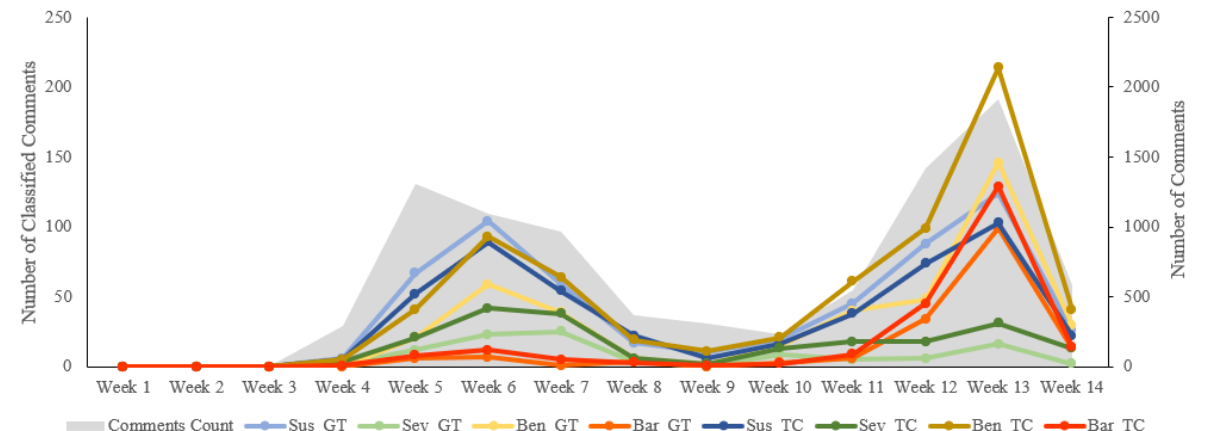
Figure 2. Classification of Ministry of Health comments with Health Belief Model constructs. The primary x-axis is for the classified comments count for the Health Belief Model constructs, while the secondary x-axis is for the total comments count. Sus refers to perceived susceptibility, Sev refers to perceived severity, Ben refers to perceived benefit, and Bar refers to perceived barrier. Suffixes GT and TC refer to ground truth and text classification,